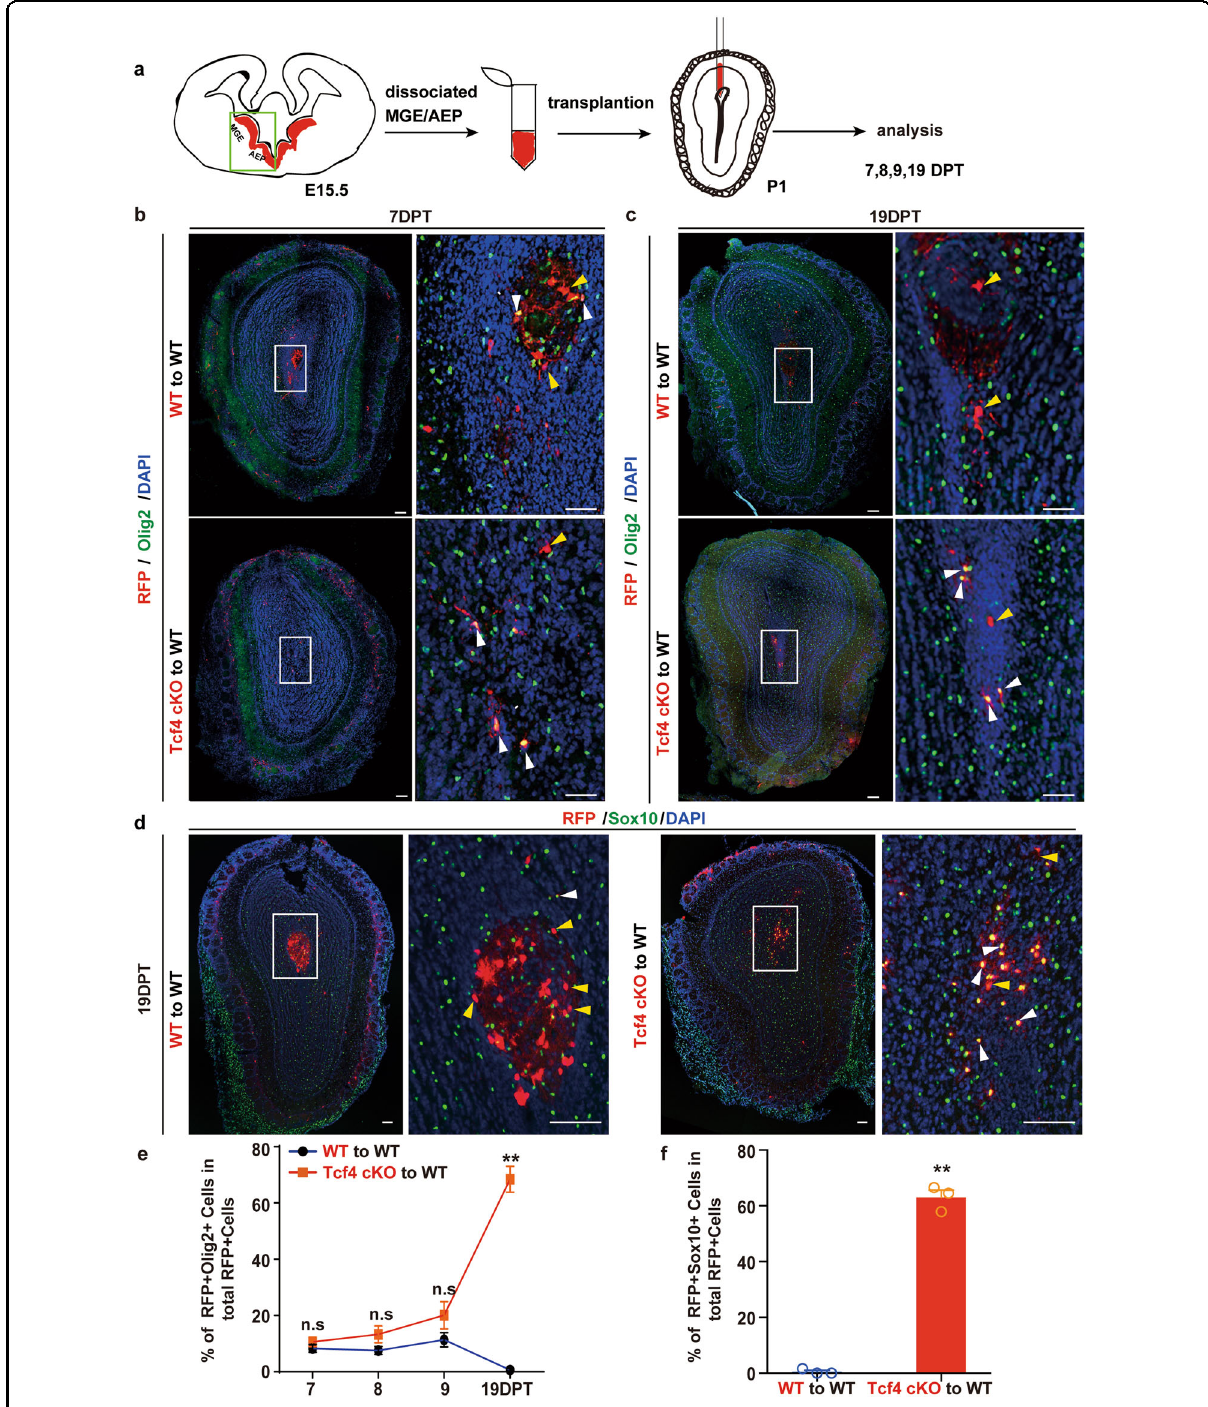
Fig. 5 Tcf4 regulates OPC survival cell-autonomously. a Schematic diagram illustrating the transplantation experiment. b – d Representative images showing that the WT or Tcf4 cKO progenitors of MGE differentiate into OPCs 7DPT ( b ), and OPCs lacking Tcf4 survived 19DPT ( c ). The survived OPCs expressing Sox10 ( d ), an OPC marker. The enlarged images were shown on the right panels. Yellow arrowheads indicate Olig2-negative cells and white arrowheads indicate OPCs. Scale bar: 100 μ m. e , f Quanti fi cations of OPCs after transplantation ( e ) and the number of Sox10-positive OPCs ( f ). Student ’ s t test was used to compare two groups. Data are presented as mean ± SEM. ** p < 0.01, n.s. nonsigni fi cant. At least three OBs were analyzed for each genotype at each time